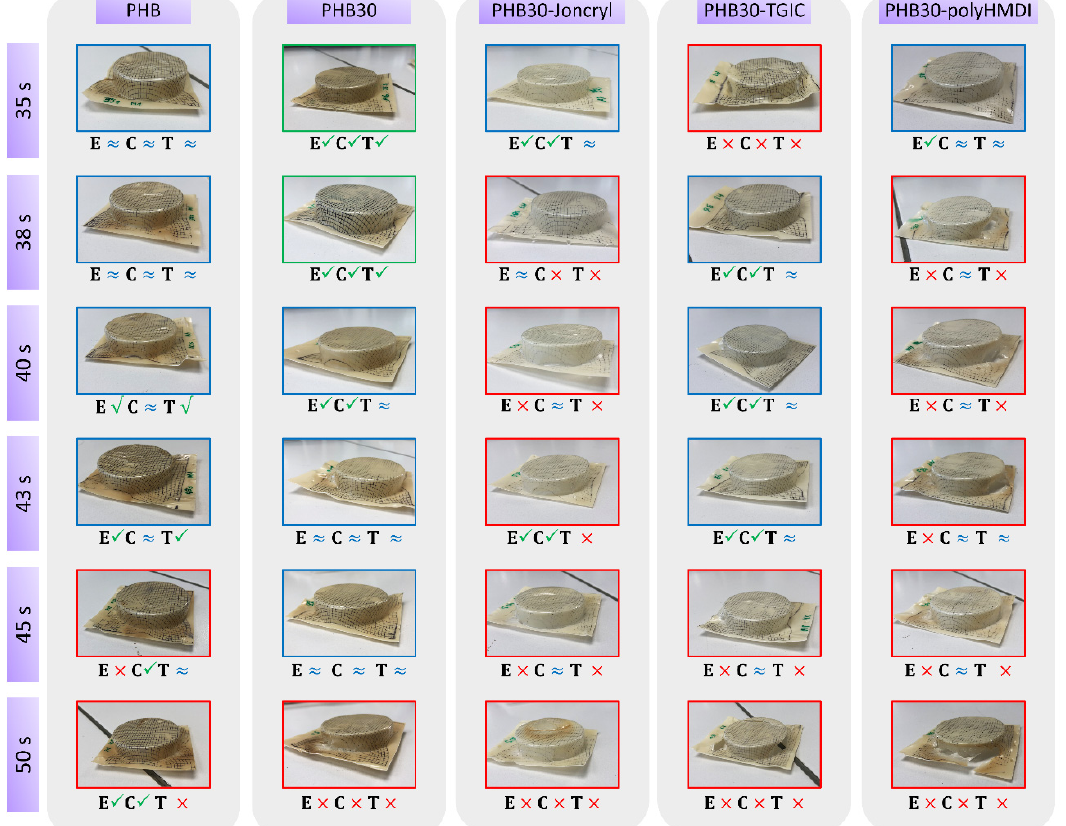
Figure 6. Photographs and assessment of thermoforming ability of the trays, showing different heating times for Neat PHB, PHB30 blend and the PHB30 compatibilized blends. The frame color indicates the overall quality of thermoforming, based upon the inspection of edges (E), corners (C) and thickness uniformity (T).